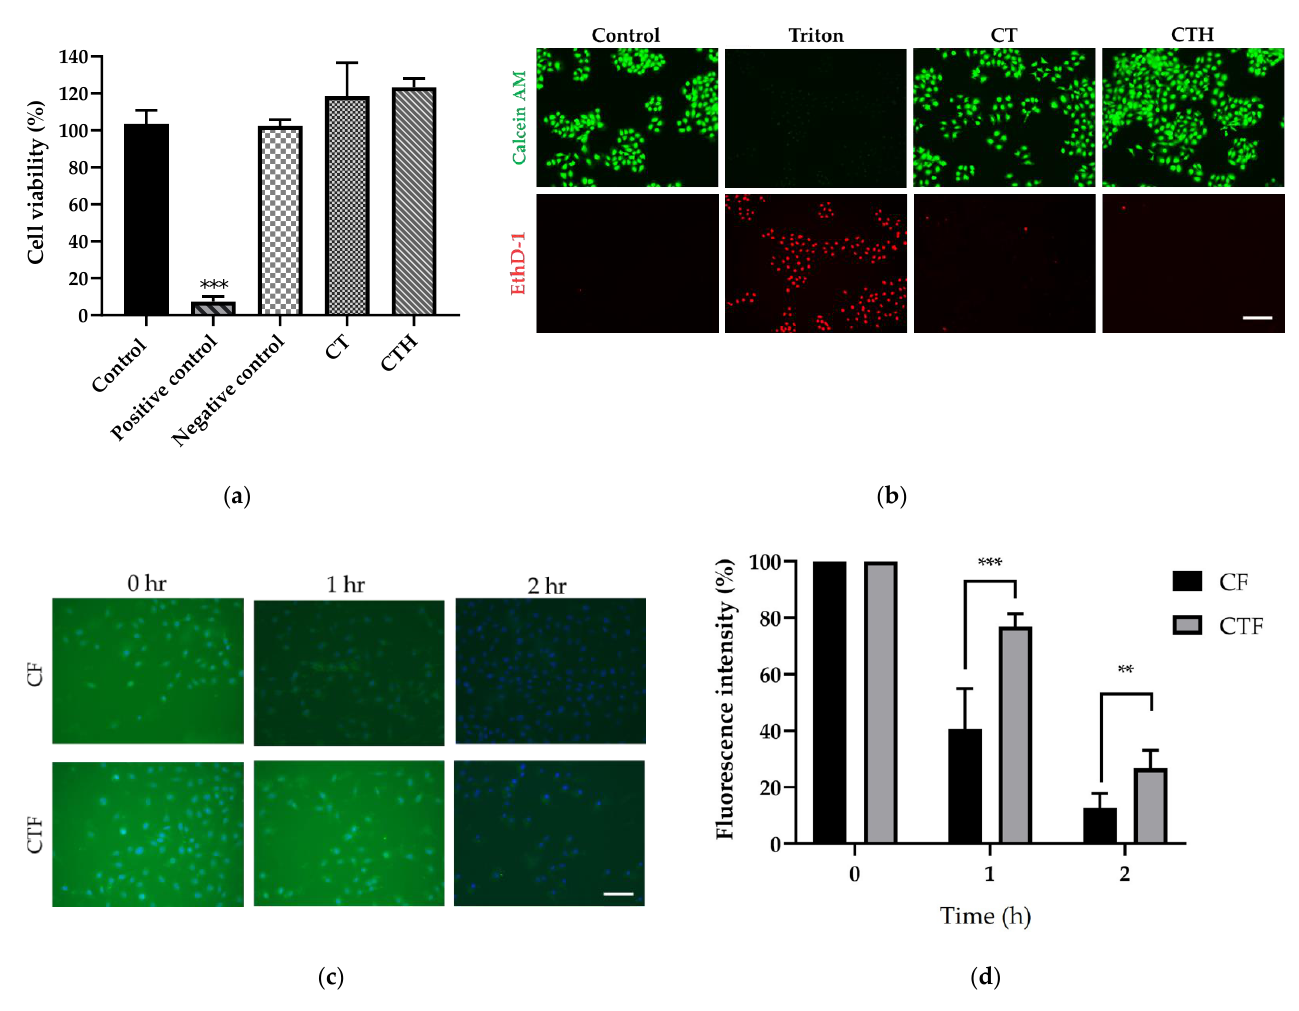
Figure 2. Evaluation of biocompatibility and mucoadhesion of CT. ( a ) WST-1 test to evaluate cell viability of CT and CTH with L929 cell. ( n = 6, *** p < 0.001) ( b ) Cytotoxicity of CT and CTH tested using live/dead staining. Living cells were stained with calcein AM and dead cells with homodimer-1 (EthD- 1) (scale bar = 100 μm). ( c ) In vitro adhesion evaluation of chitosan -FITC (CF) and CT-FITC (CTF). The fluorescence microscope was used to observe material adhesion on mucus. ( d ) Fluorescence quantification of the in vitro adhesion test. One-way ANOVA ( n = 3, ** p < 0.01 *** p < 0.001).